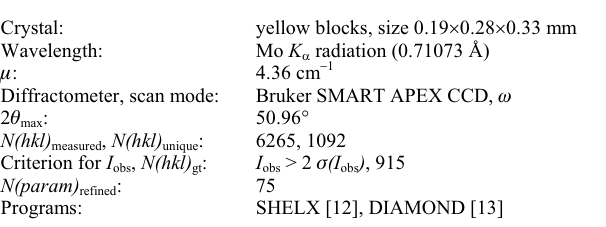
Table 1. Data collection and handling.